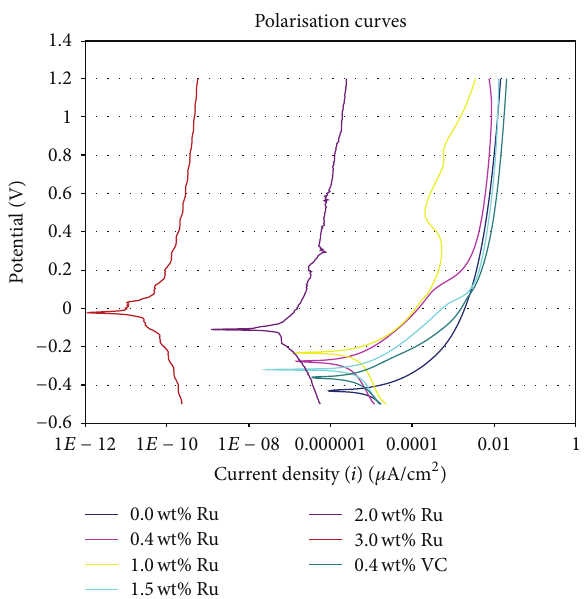
Figure 7: Comparative corrosion behavior of WC-Co in synthetic mine water with increasing additions of Ru and